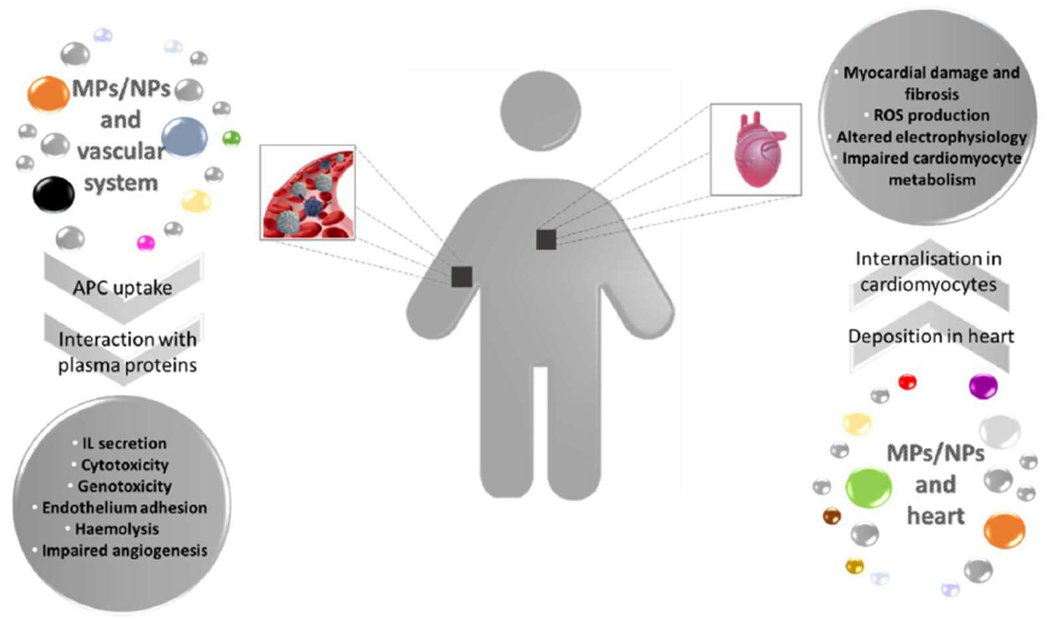
Figure 2. MPs and NPs effects on vascular system and heart in mammals. Plastic fragments enter the human body through different routes and are internalised within the cells of vascular system where they can trigger several cellular responses. Additionally, MPs/NPs reach the cardiac tissue causing structural and metabolic damages. IL =